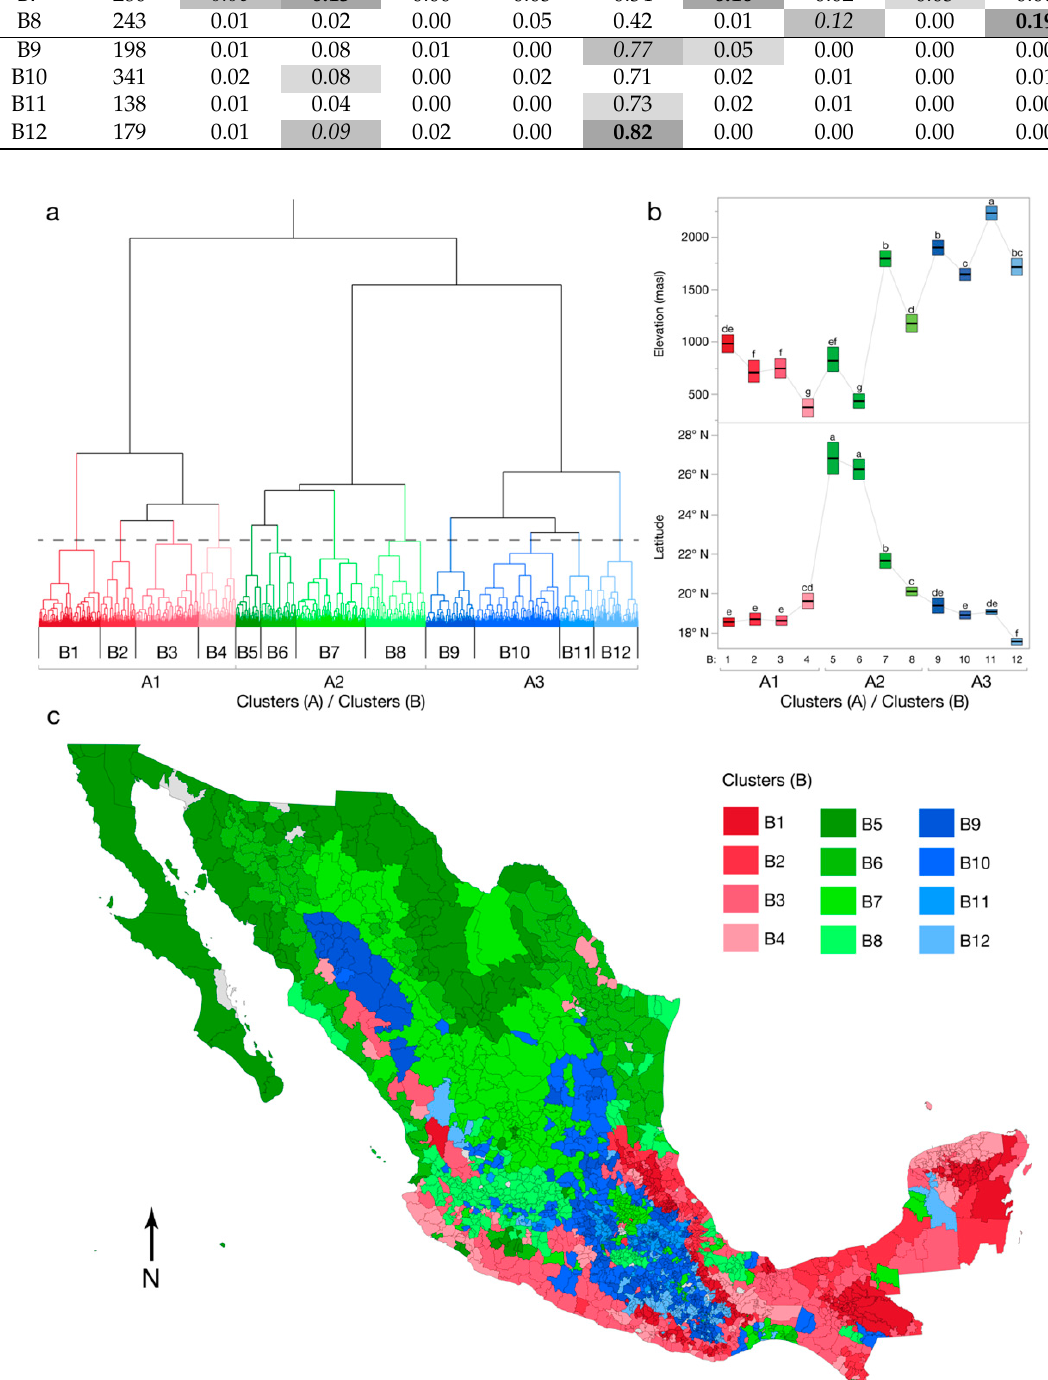
Figure 2. ( a ) Dendrogram of 12-cluster (B) solution (CCC = 9.06). ( b ) Differences in elevation and latitude with different letters (a–g) indicating statistical significance as determined by Kruskal–Wallace and Dunn’s post hoc tests. ( c ) Mapped clusters with omitted municipalities shaded gray.